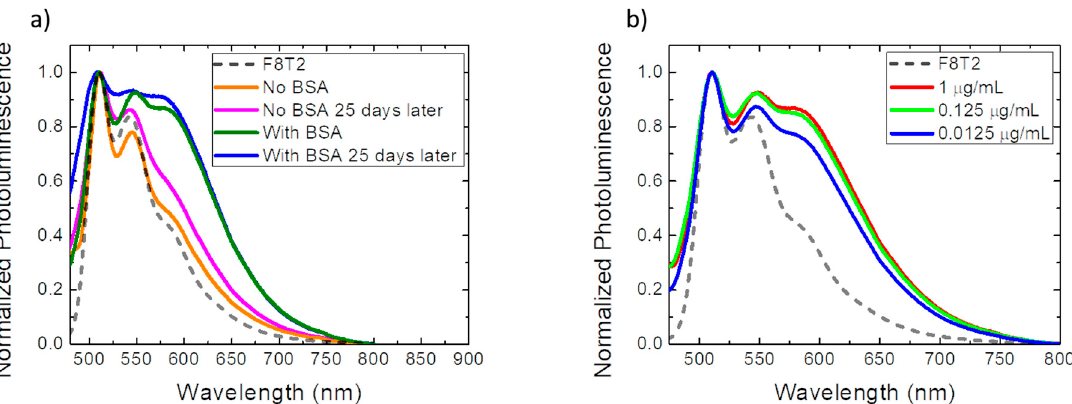
Figure 4. ( a ) Normalized photoluminescence spectrum of the optical biosensor for stability study; ( b ) normalized photoluminescence spectrum of the optical biosensor for the study of the concentration. The photoluminescence spectrum of the film with F8T2 was plotted by comparison.